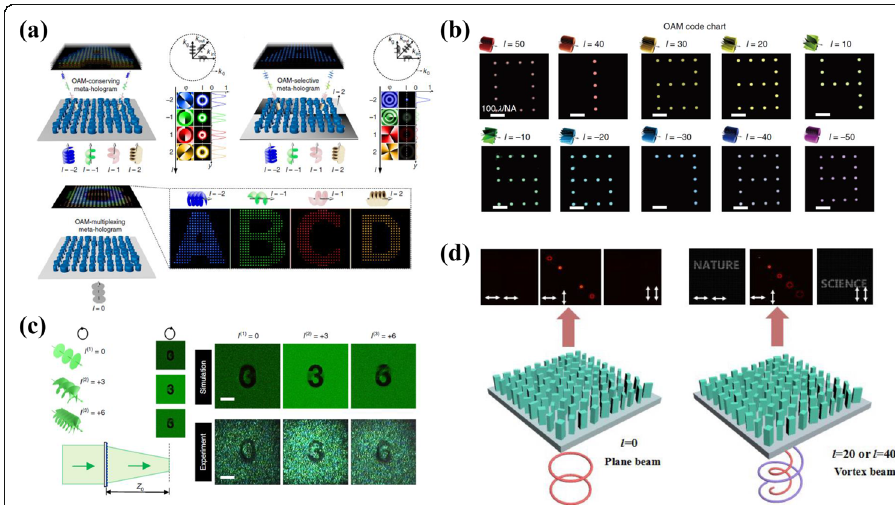
Fig. 5 OAM-multiplexed metasurface holography. a Schematic illustrations of OAM-conserving, − selective, and -multiplexing meta-holograms. The OAM-multiplexing meta-hologram can reconstruct multiple distinctive holographic images by using different OAM modes [83]. b A 10 bit OAM-multiplexing hologram for high-security holographic encryption. Ten high order OAM modes can be used to reconstruct ten OAM- dependent digits [84]. c An OAM meta-transformer which can reconstruct “ 0 ” , “ 3 ” and “ 6 ” by designed three OAM states, respectively [85]. d The principle of vortex and polarization encryption based on proposed metasurfaces. Different holographic images can be reconstructed by either Gaussian beams ( l = 0) or vortex beams carrying a specific OAM ( l = 20 or 40) at different polarization channels